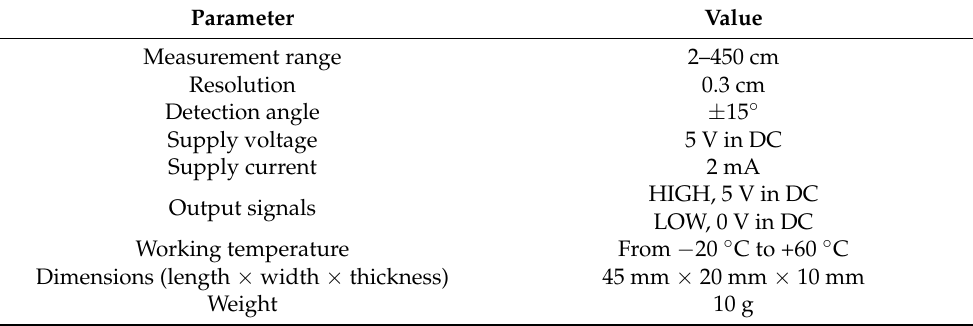
Table 1. Datasheet of HY-SRF05.